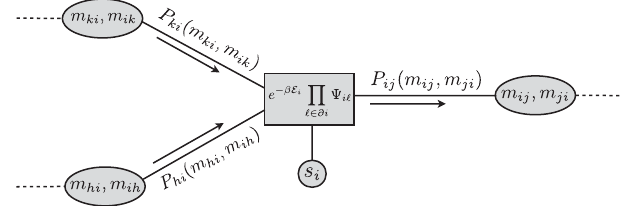
FIG. 3. Factor-graph representation of the BP equations for the optimal immunization problem in the SIR model. Variable nodes are of two types: One type includes pairs of auxiliary variables fð m ij ; m ji Þg ; the other includes the immunization variables f s i g . There is a factor node for each node i of the original graph, including the energetic term E i and all hard constraints f Ψ i l g involving node i as a first